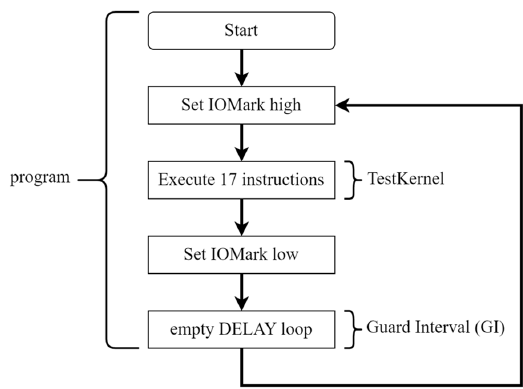
Figure 10. TestKernel flowchart.